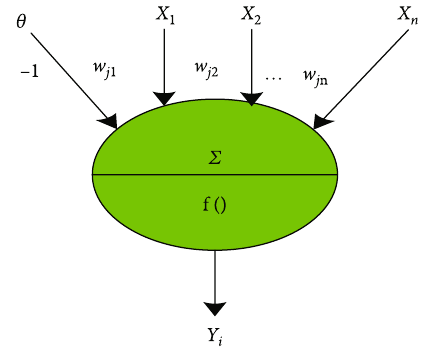
Figure 2: Schematic diagram of a single